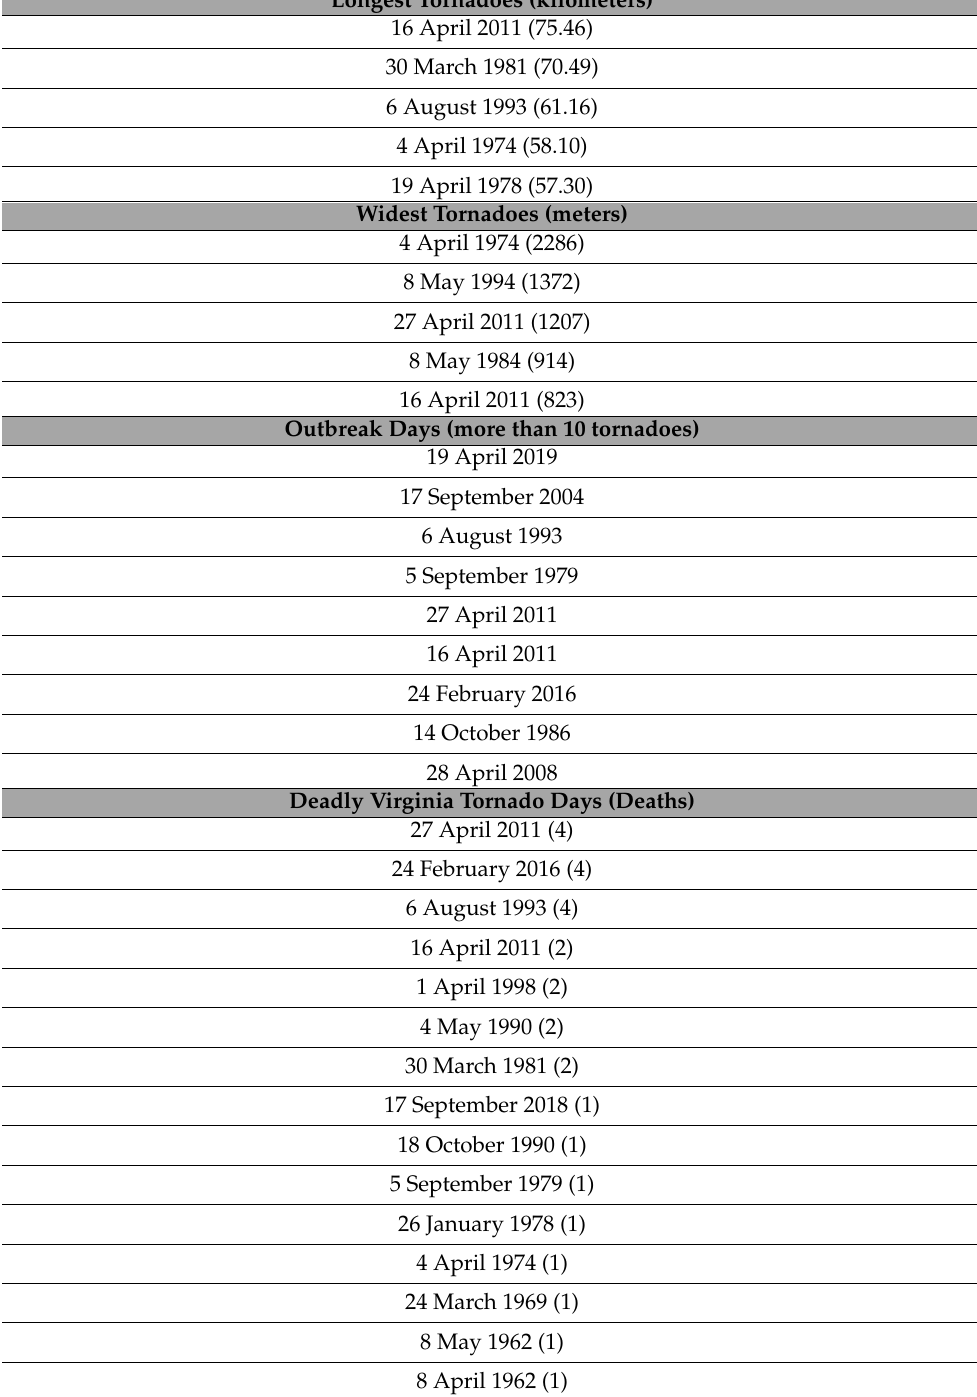
Table 1. Notable Virginia tornado